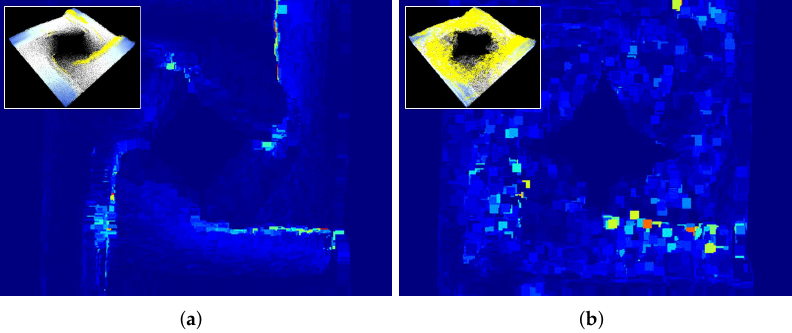
Figure 4. Acceleration map projected onto screen-space (red: fast acceleration, blue: slow acceleration, inset image: simulation view) ( a ) Frame 115. ( b ) Frame